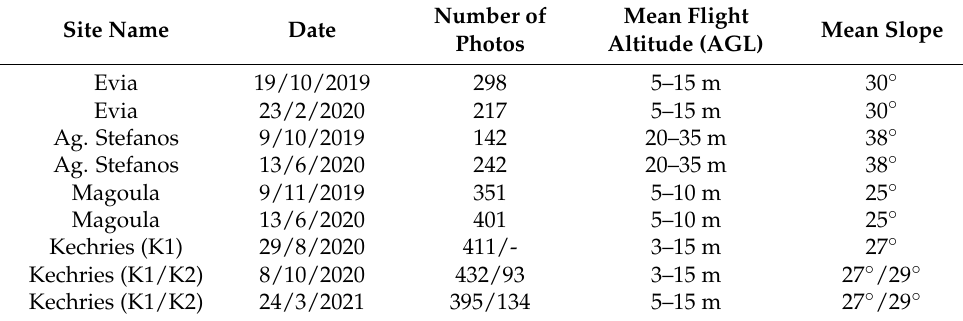
Table 2. UAV flight and image acquisition characteristics for each site.